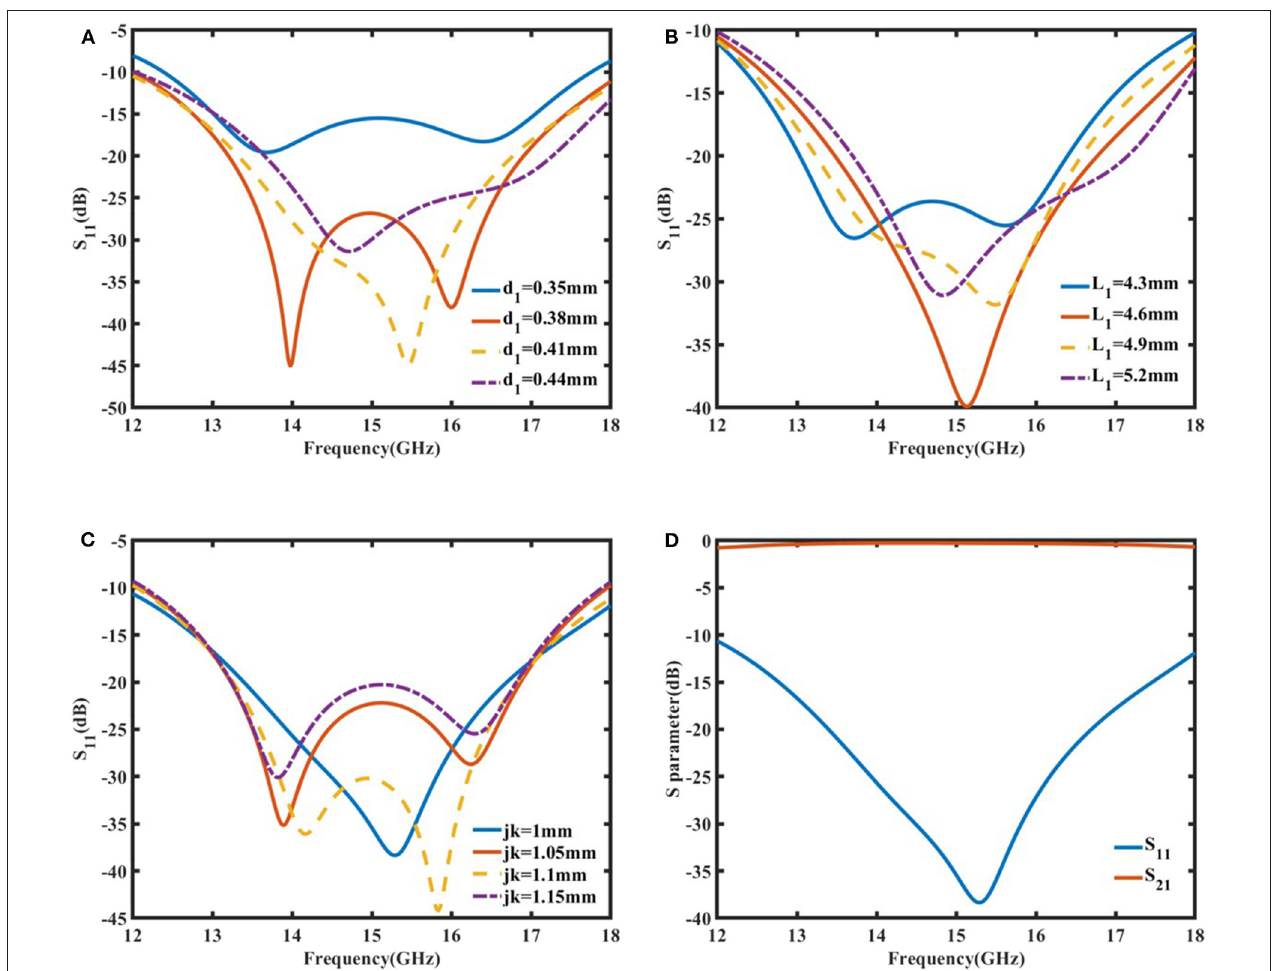
FIGURE 3 | The simulated reflection ( S 11 ) when (A) the height d 1 , (B) the length L 1 , and (C) the thickness jk of the first ridge are changed. (D) The simulated reflection ( S 11 ) and transmission ( S 21 ) from the rectangular waveguide to the microstrip line when d 1 = 0.42 mm , L 1 = 4.8 mm , jk = 1 mm .